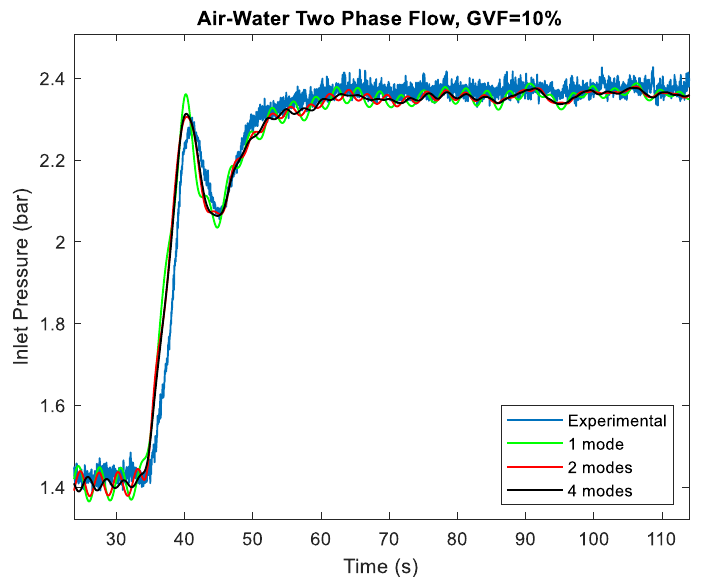
Figure 7. National University of Singapore (NUS) experimental results vs. Low-D model predictions